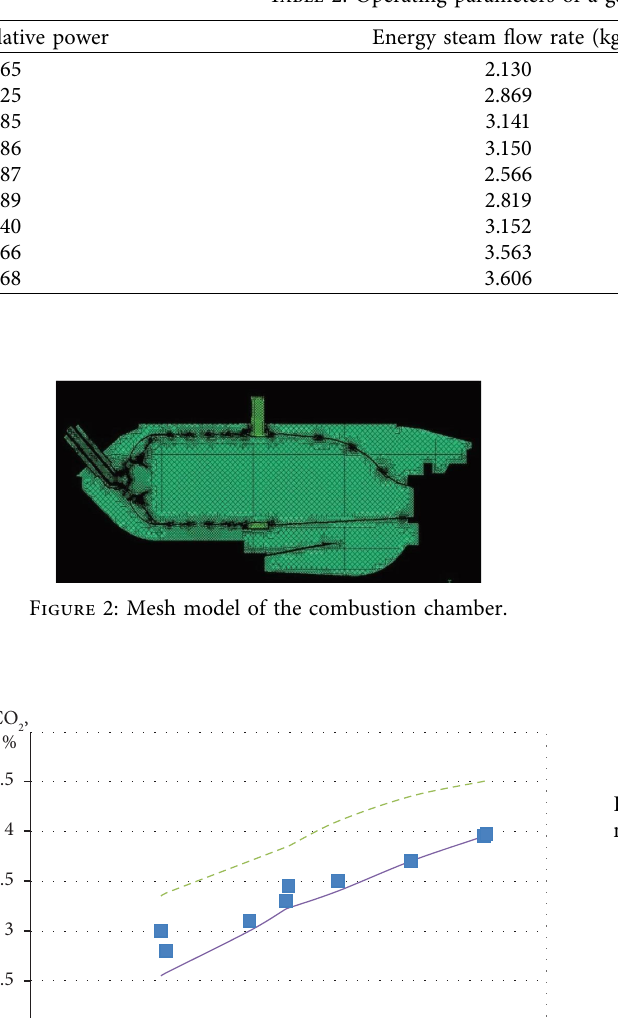
Table 2: Operating parameters of a gas turbine combustion chamber.